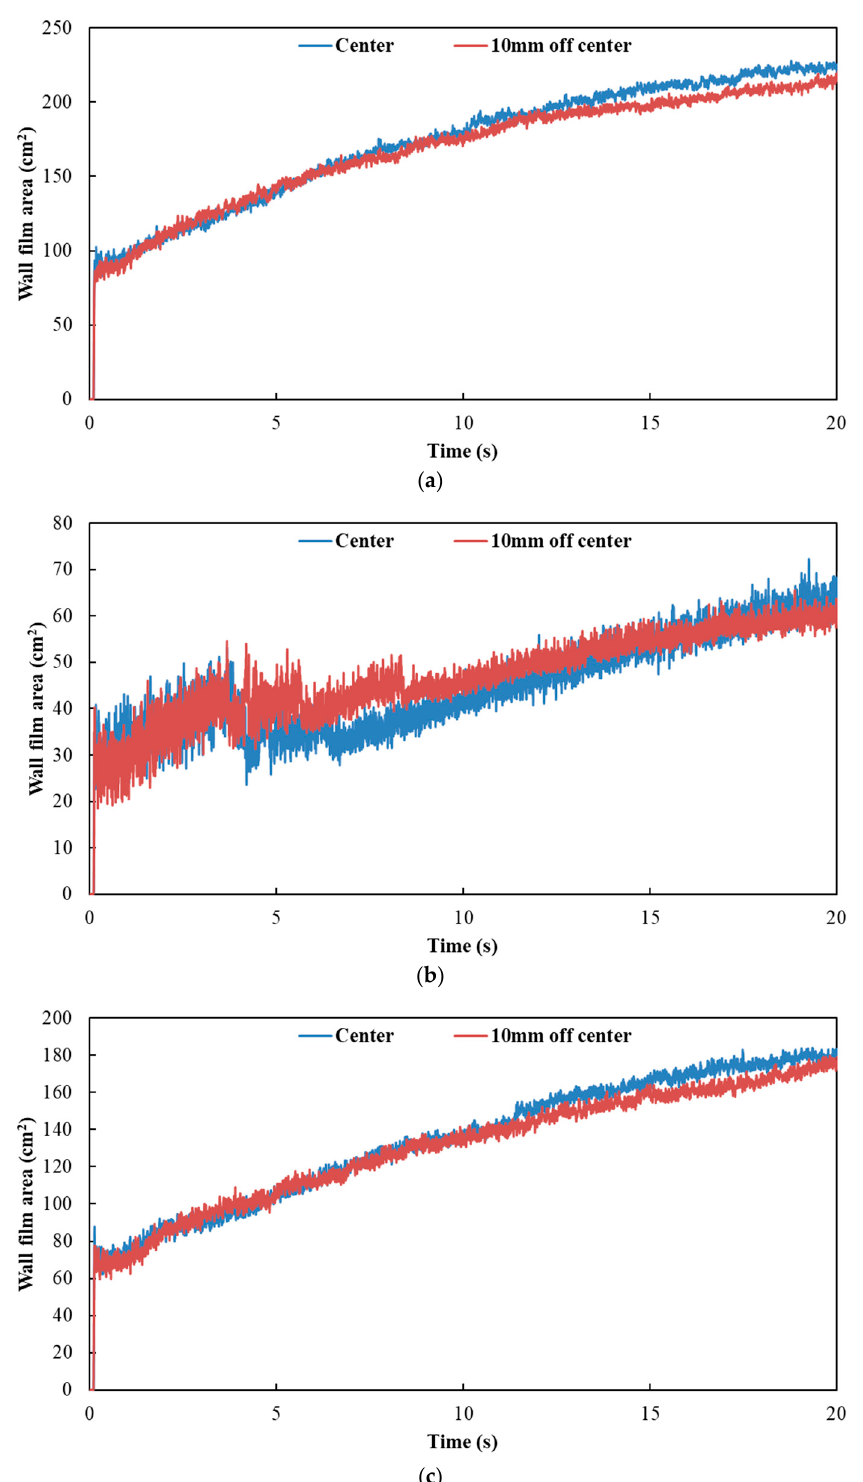
Figure 15. Influence of different nozzle positions on wall film area . ( a ) Case 1; ( b ) Case 2; ( c ) Case 3 .